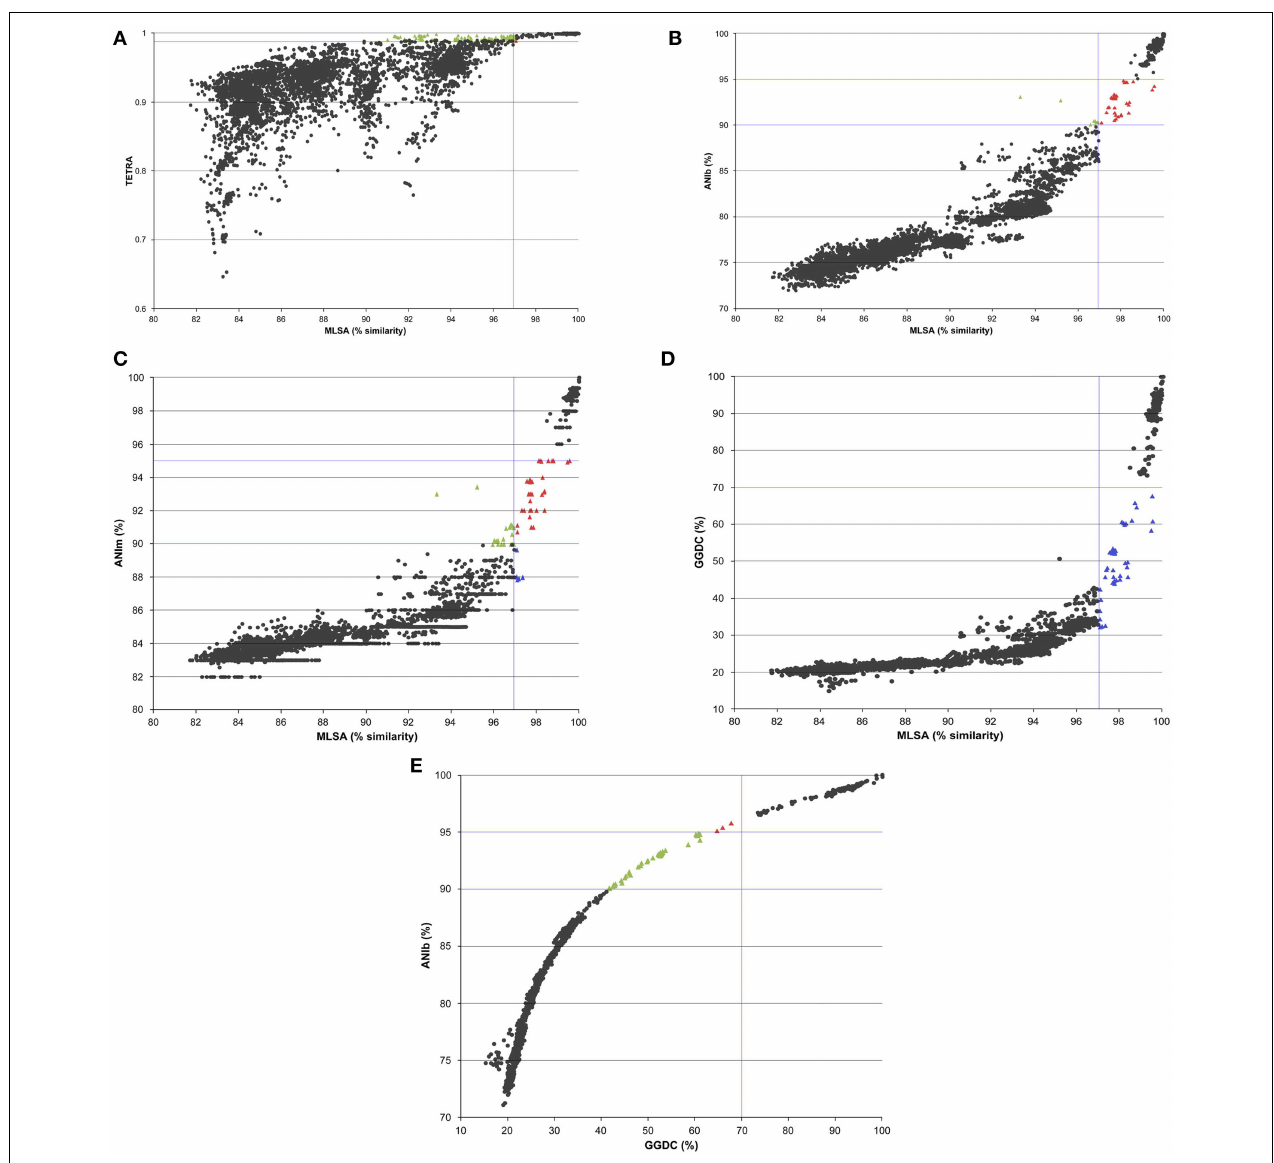
FIGURE 2 | Graphs representing the relationship between TETRA (A), ANIb (B), ANIm (C), and GGDC (D) indices vs. MLSA sequence similarity for the genomes studied; (E) shows the relationship between ANIb and GGDC indices. Each dot represents a pairwise comparison; the genomic indices are plotted against the corresponding MLSA sequence similarity. TETRA signatures values in black circles indicate TETRA < 0.99 and MLSA < 97% and TETRA > 0.99 and MLSA > 97%; green triangles indicate TETRA > 0.99 and MLSA < 97%; and red triangles